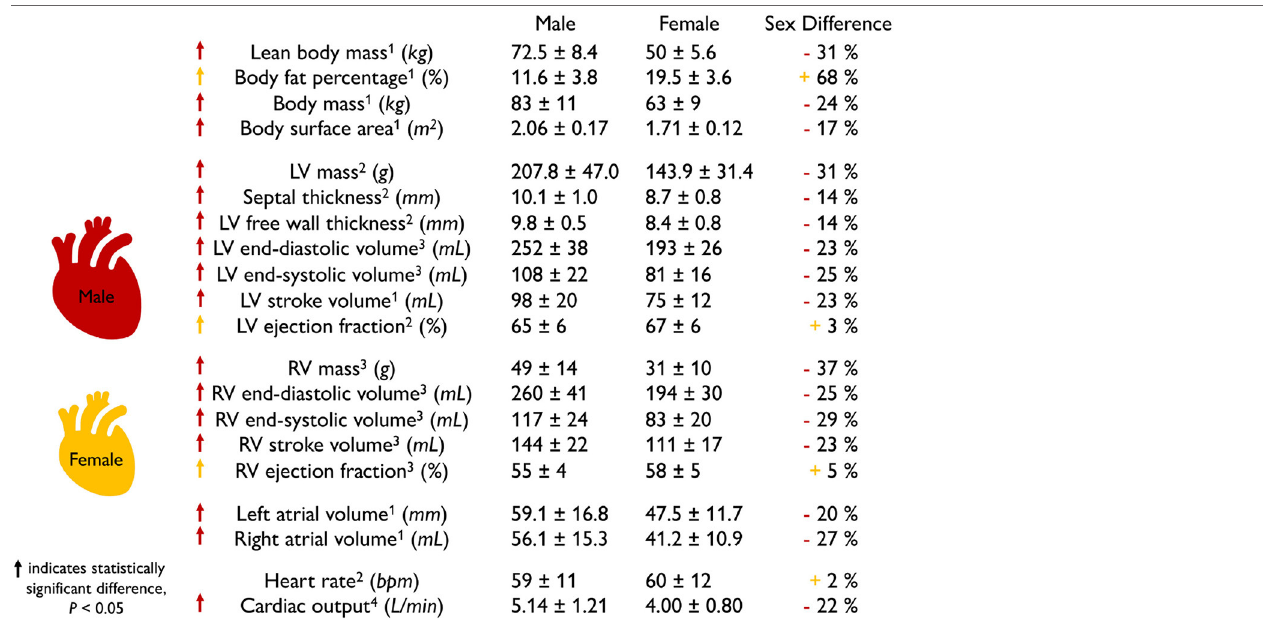
Similar to the healthy population, the male athlete’s heart has greater heart mass, volume, and cardiac output than the female athlete’s hearts, while the female athlete’s heart has slightly greater ejection fractions. Male and female characteristics and sex difference are reported in percent, with the male heart as the baseline. Negative values in red indicate that the female parameter is smaller; arrows indicate reported statistically significant differences; quantitative data are represented as mean absolute value ± SD; [1] Giraldeau et al. (2015); [2] D’Ascenzi et al. (2020); [3] Csecs et al. (2020); [4] Cote et al. (2015).